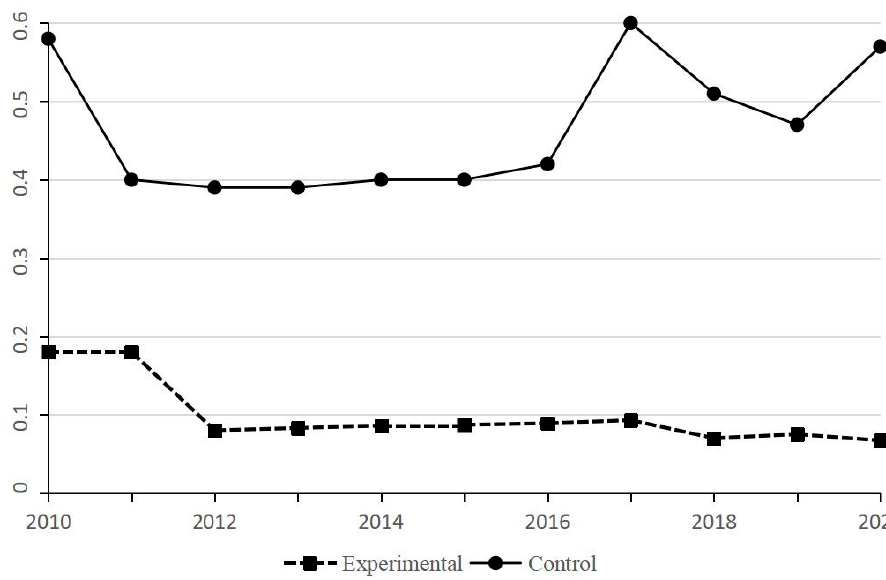
Figure 2. Parallel trend test results.